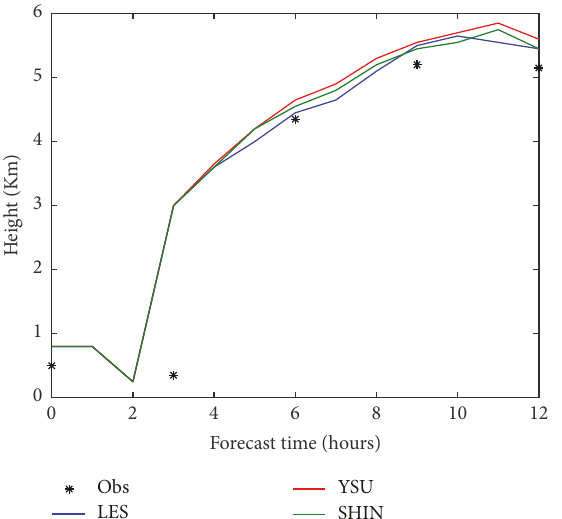
Figure 5: Time-height cross-section of the potential temperature differences at Tazhong station between (a) YSU, (b) Shin-Hong, and WRF-LES experiment,